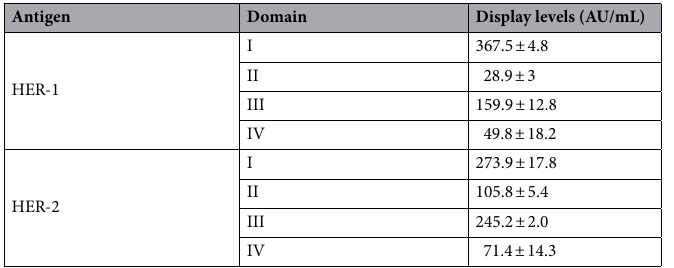
Table 1. Display levels of the individual HER domains. Phages displaying every individual HER domain were rescued with M13KO7 helper phage and purified through polyethylene glycol precipitation. Each phage preparation was diluted and titrated on polyvinyl chloride microplates coated with the anti- c-myc tag antibody 9E10. Bound phages were detected with an anti-M13 antibody conjugated to horseradish peroxidase. The standard curve of phages displaying c-myc only with no fused protein was simultaneously evaluated and used to calculate the relative display levels for each preparation. A display level of 100 arbitrary units (AU)/ mL was assumed for the undiluted standard. Numbers indicate the mean value ± standard deviation of three independent phage preparations displaying each